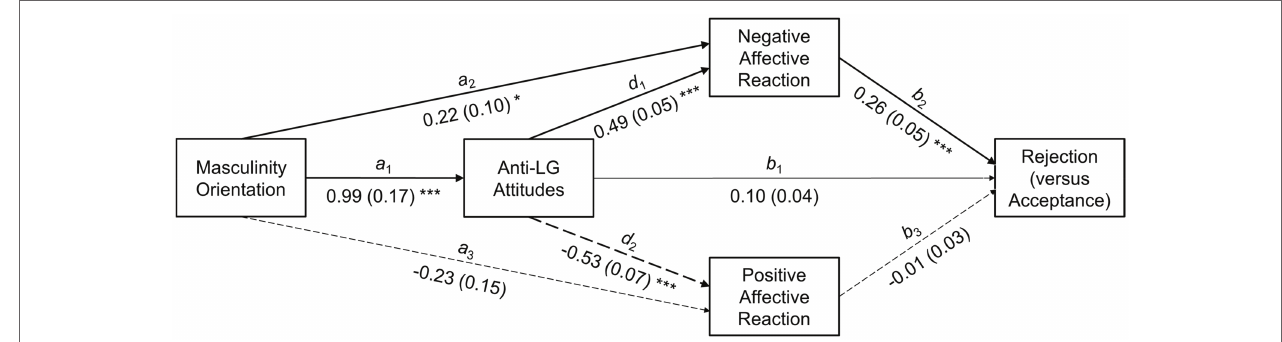
FIGURE 2 | Statistical mediation model for the association between masculinity orientation and anticipated reactions toward the child’s coming out. Dashed and solid paths indicate statistically significant negative and positive associations, respectively. Thin paths indicate non-significant associations. Path coefficients are unstandardized regression weights ( B s); their standard errors ( SE s) are in parentheses. * p < 0.05, ** p < 0.01, and *** p < 0.001.